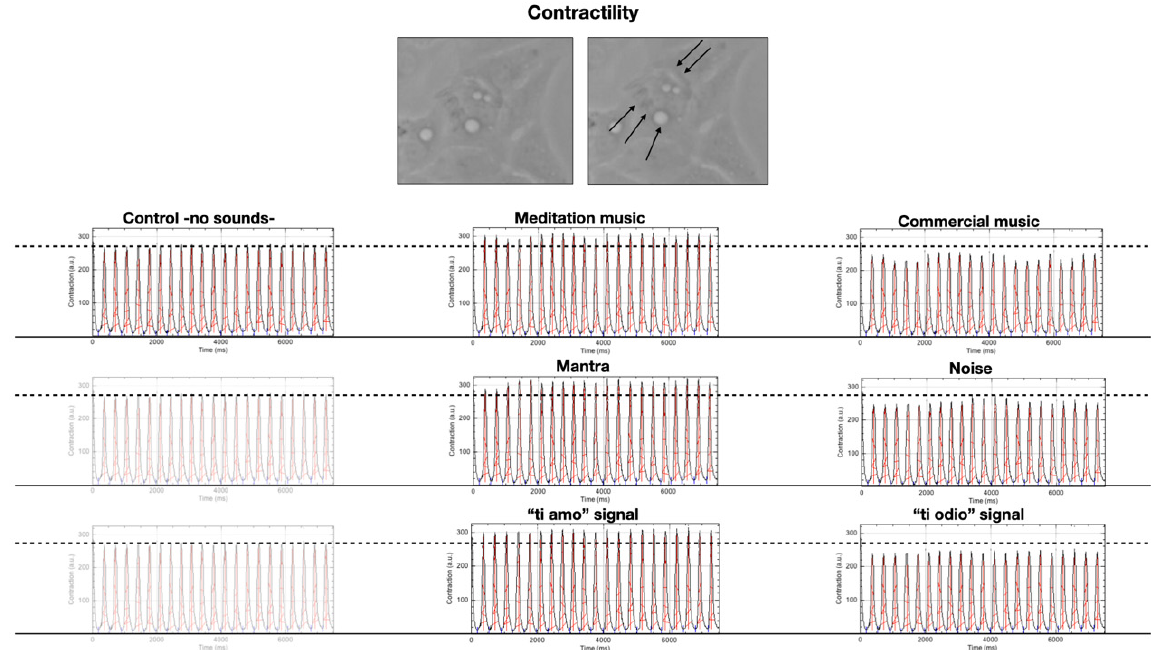
Figure 2. Contractility analysis of the same cell (at the top of the panel, black arrows indicate the contraction—magnification 63 × ) under the different acoustic stimulations. The graphics represent Contraction (a.u.) vs. Time (ms).